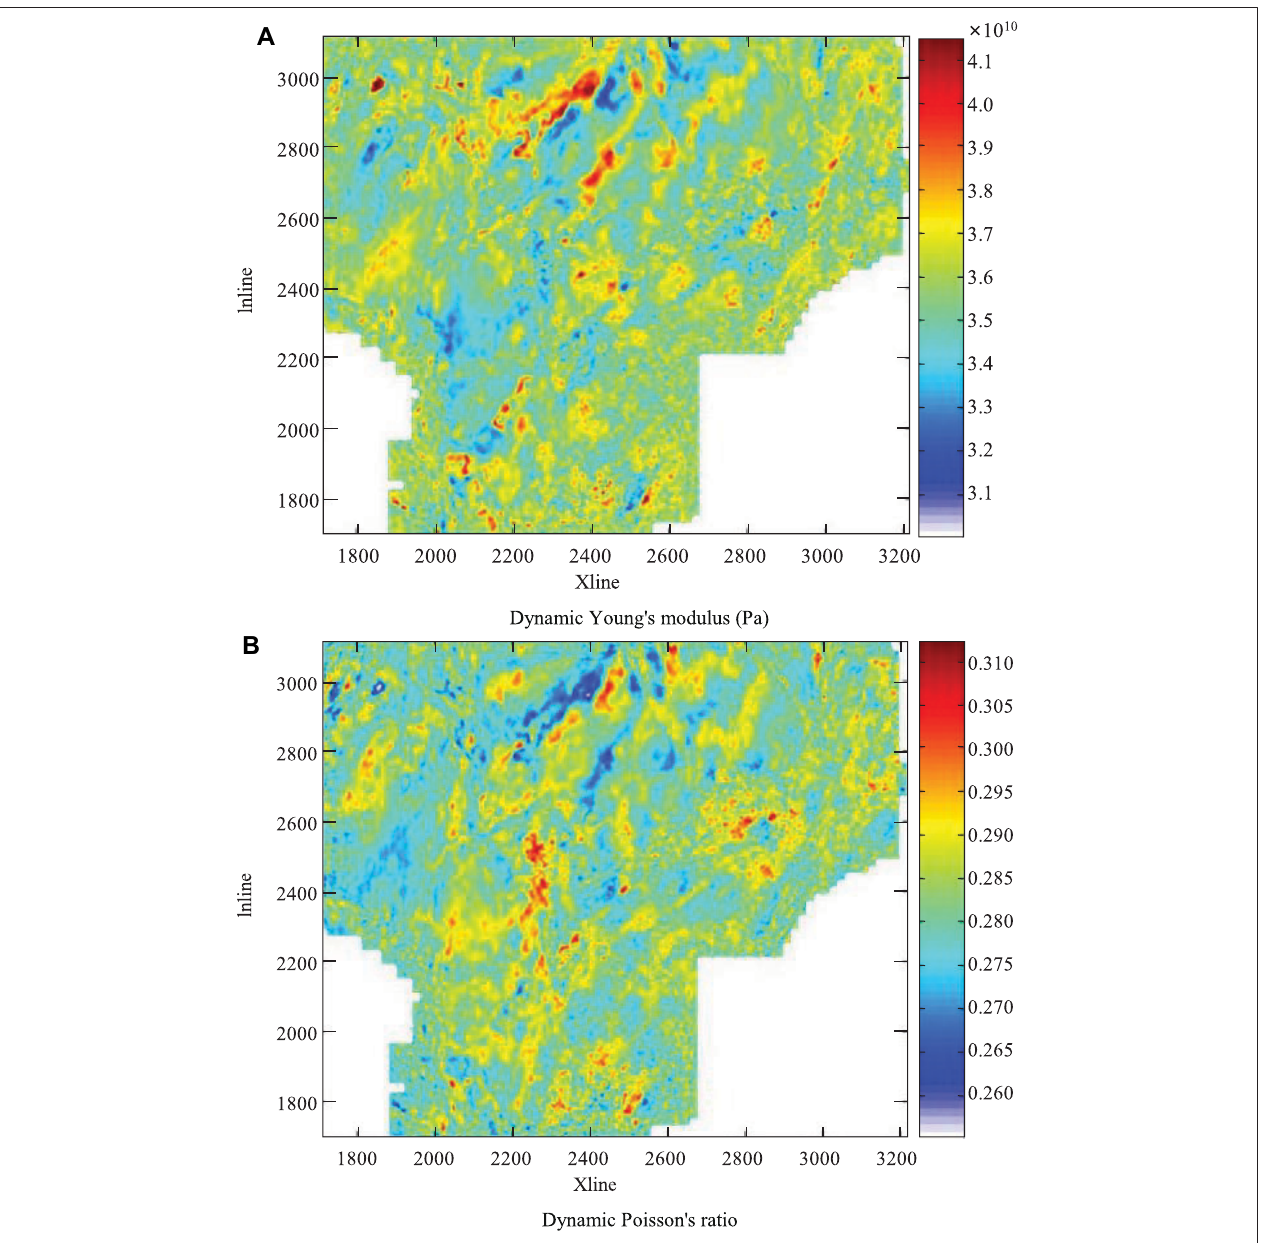
FIGURE9| Slicing ofdynamic Young ’ s modulus and Poisson ’ sratioalongstrata ofthe Longmaxi formationin Dingshan area. (A) DynamicYoung ’ s modulus (Pa). (B) Dynamic Poisson ’ s ratio.